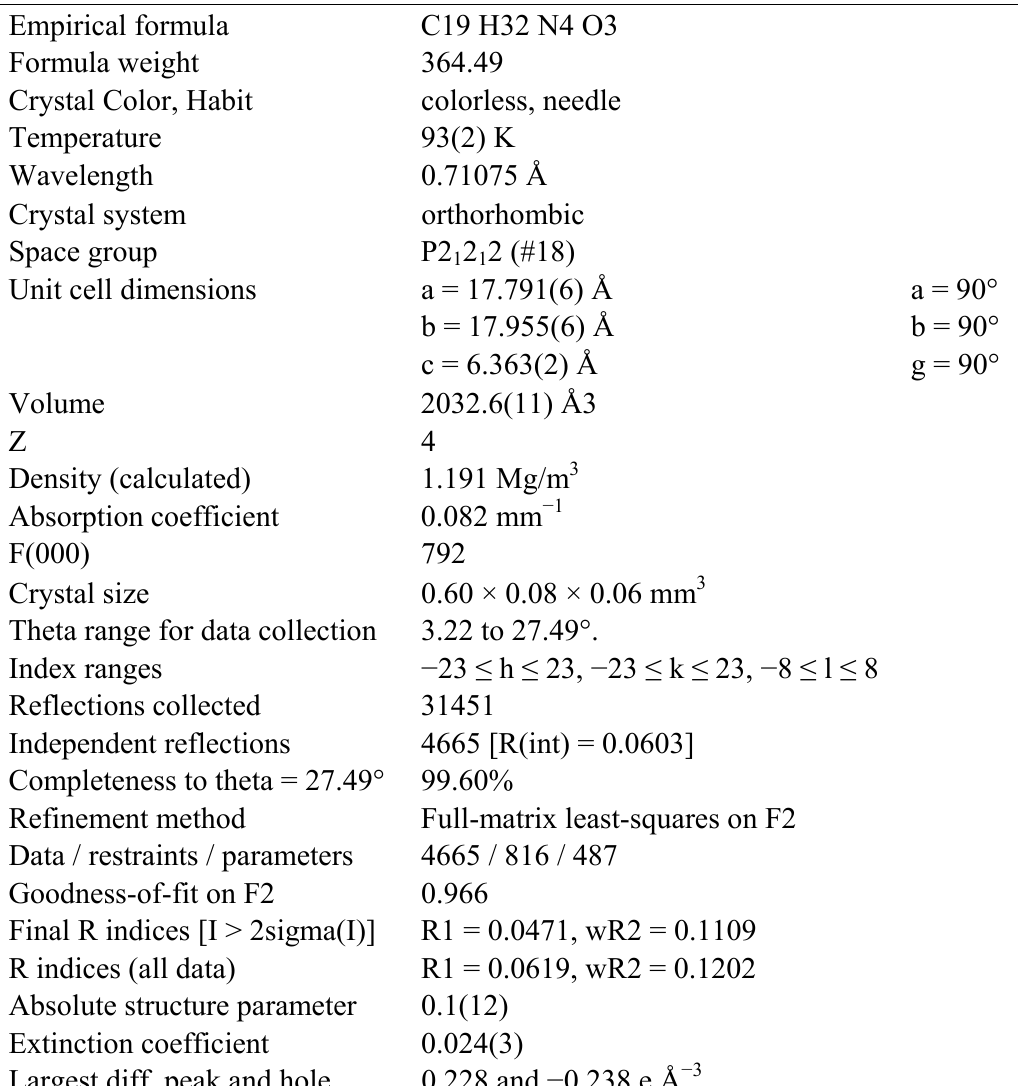
Table 6. Crystal data and structure refinement for